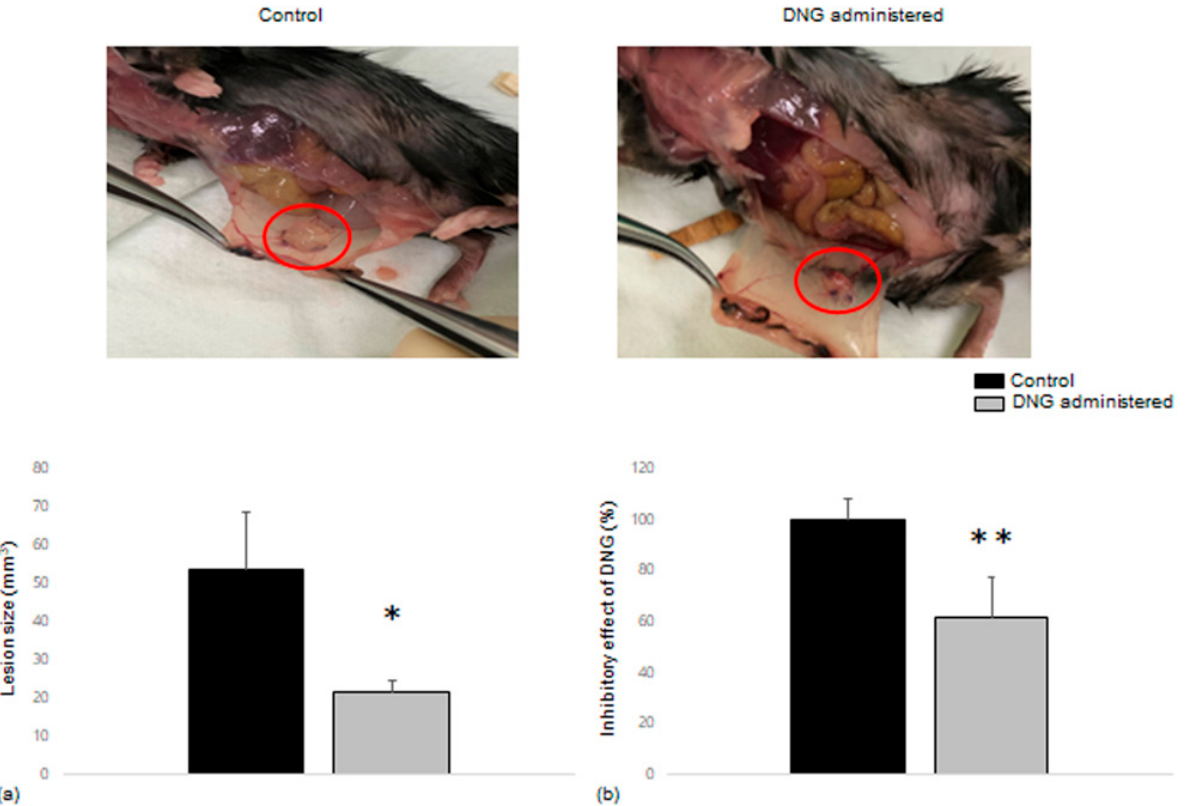
Figure 5. Effect of DNG on ectopic endometrial tissue growth in mice. ( a ) Image and graph showing ectopic endometrial tissues in control mice and DNG-treated mice. ( b ) The size change of the im- planted tissues and paired comparison allotransplanted from the same uterus of a mouse, showing the inhibitory effect of DNG. * p = 0.049 vs. control. ** p = 0.019 vs. control.